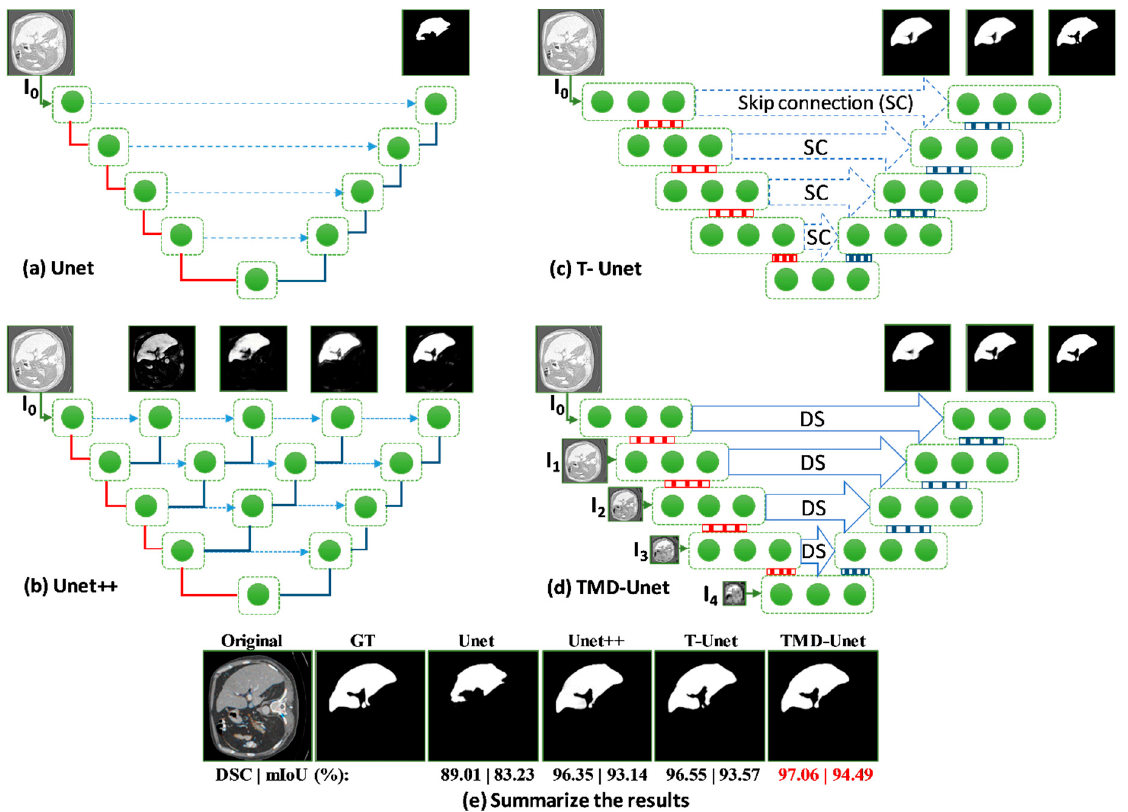
Figure 7. Visualization of the feature maps from the inputs and outputs on the models for the liver CT image. The ( a – d ) show the structure and output features of Unet, Unet++, T-Unet, and TMD-Unet, respectively. The ( e ) presents the final outputs and the metrics of all the models. The red lines indicate max-pooling while the blue lines are transposed convolution. The green dot denotes the convolution unit of the node.